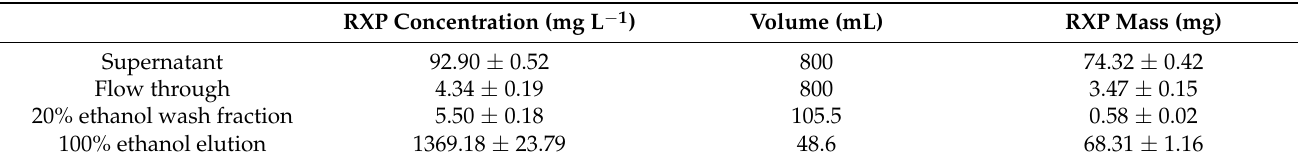
Table 2. RXP capture from 800 mL fermentation supernatant in a 5 mL column packed with XAD-16N resin at 30 ◦